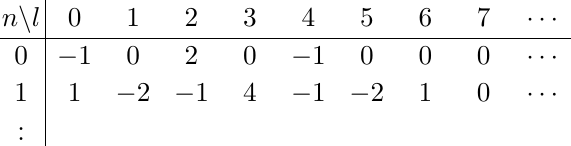
Table 1 . Coefficients A l,n